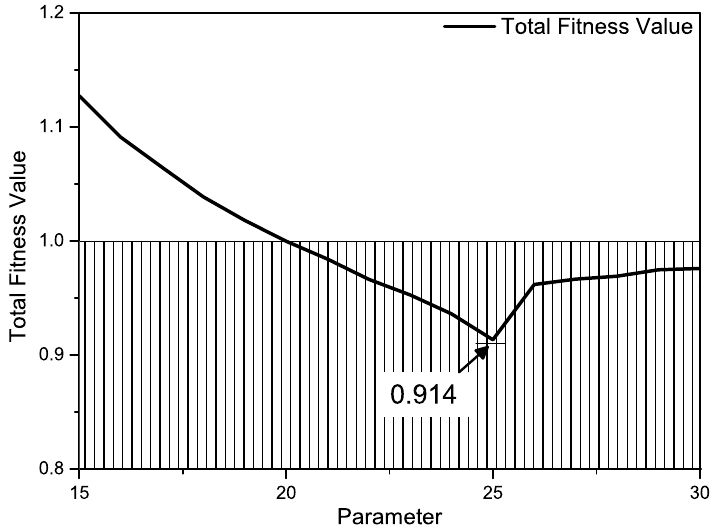
Figure 9. The total fitness value for finding the optimal